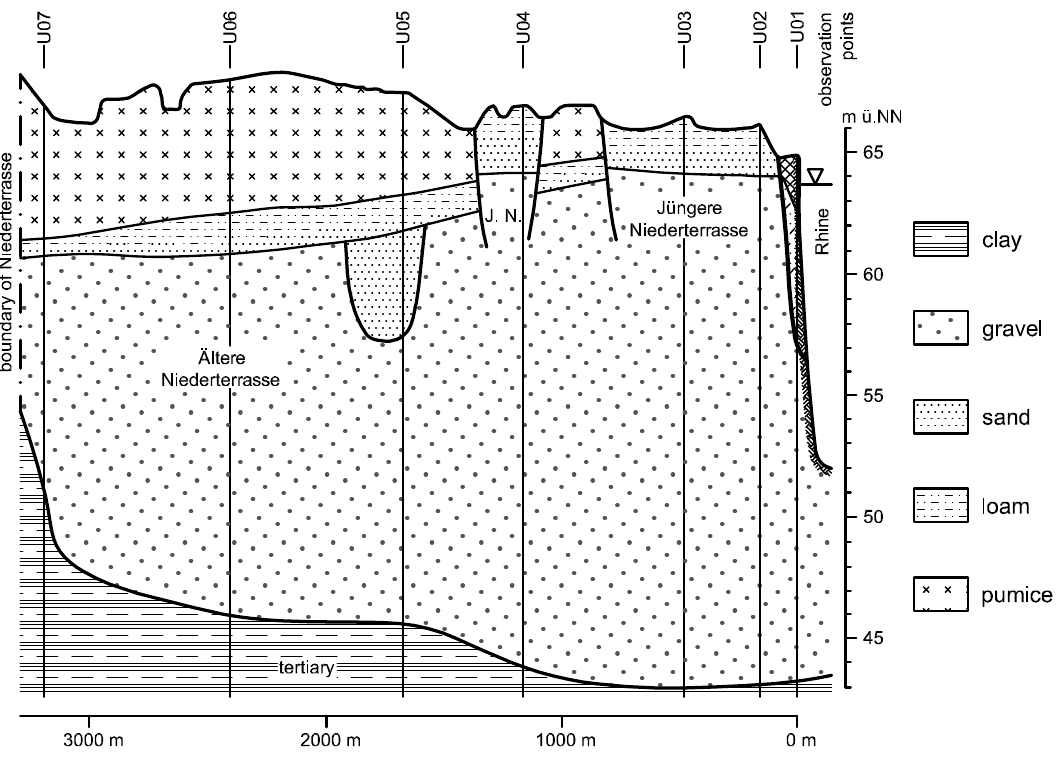
Figure 5. Hydrogeological cross-sectional profile of the Rhine valley near Urmitz